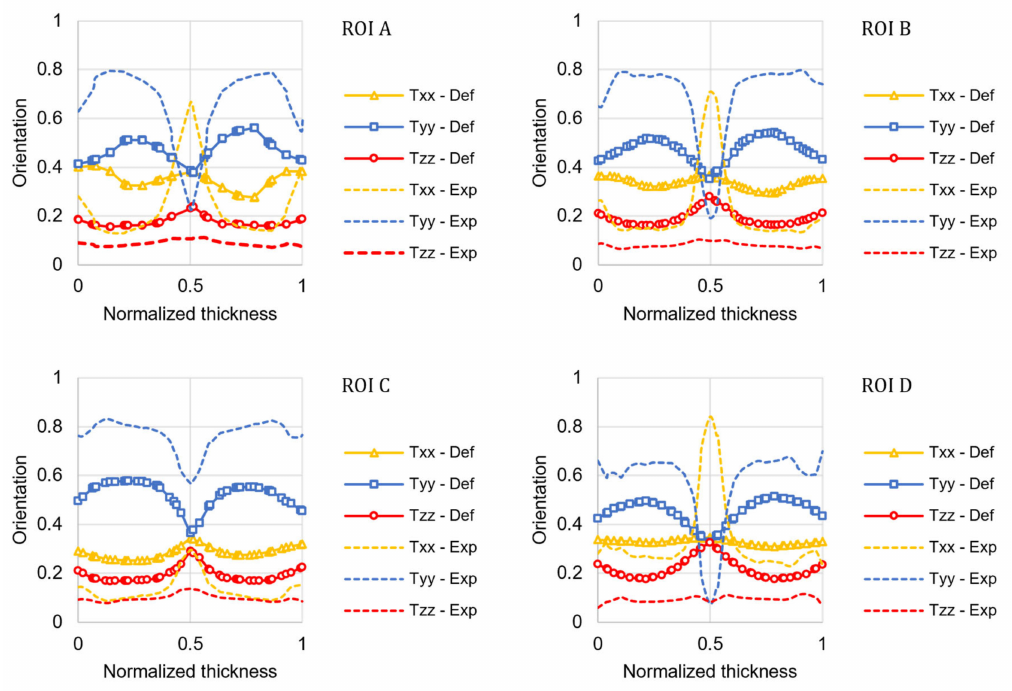
Figure 4. Comparison between the experimental results (Exp) of the fiber orientation tensor principal components and the numerical results predicted using the default coefficients of the RSC model (Def) for the four ROIs in the